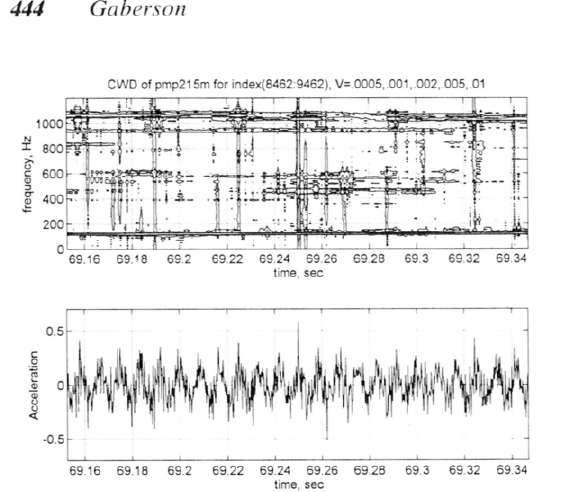
FIGURE 11 Time history and CWD contour plot from pump